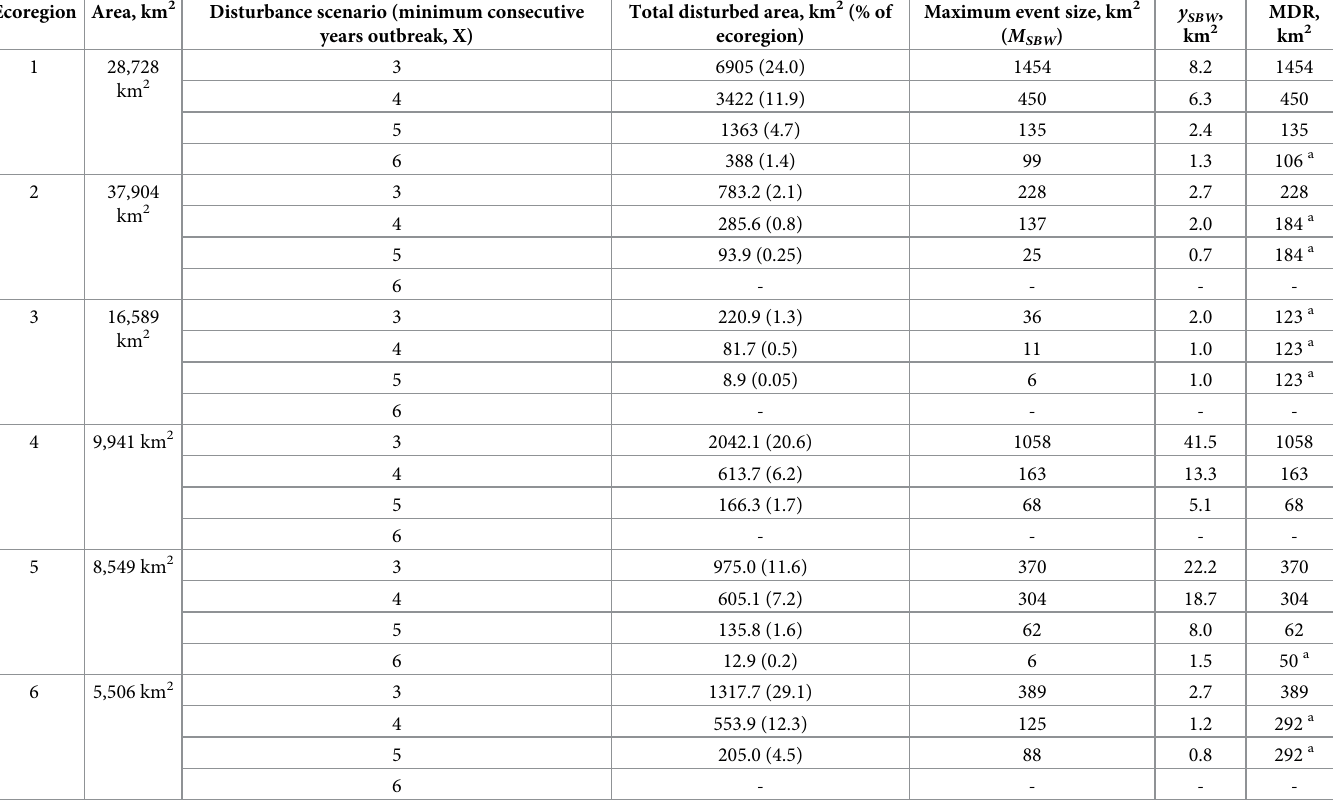
Table 1. Spruce budworm MDR results. Ecoregion area and total area of disturbance footprint are shown for each ecoregion and X scenario, along with M SBW , y SBW and the final MDR value. Ecoregion Area, km 2 Disturbance scenario (minimum consecutive Total disturbed area, km 2 (% of years outbreak, X)